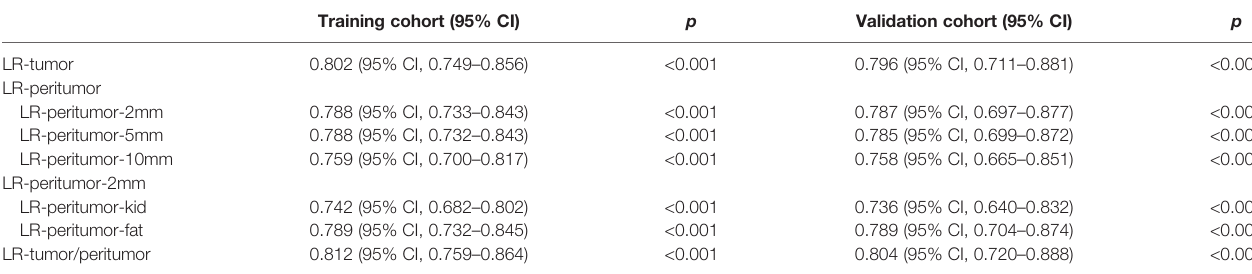
TABLE 1 | The AUCs of tumoral and peritumoral radiomic